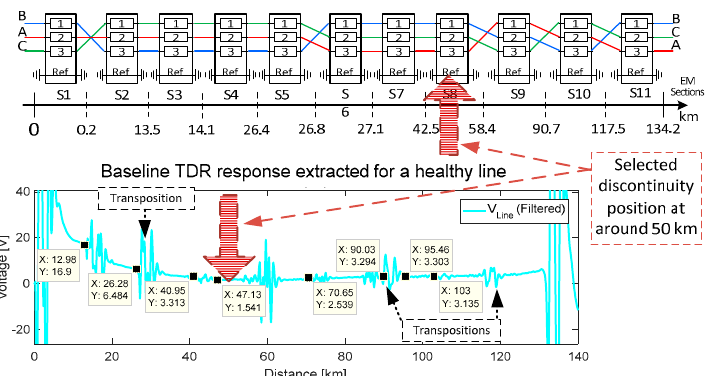
Figure 11. Equivalent electromagnetic line modeling versus the baseline TDR response in the case of no degraded joints along the line and subsequent placement of the lumped impedance at 50 km.